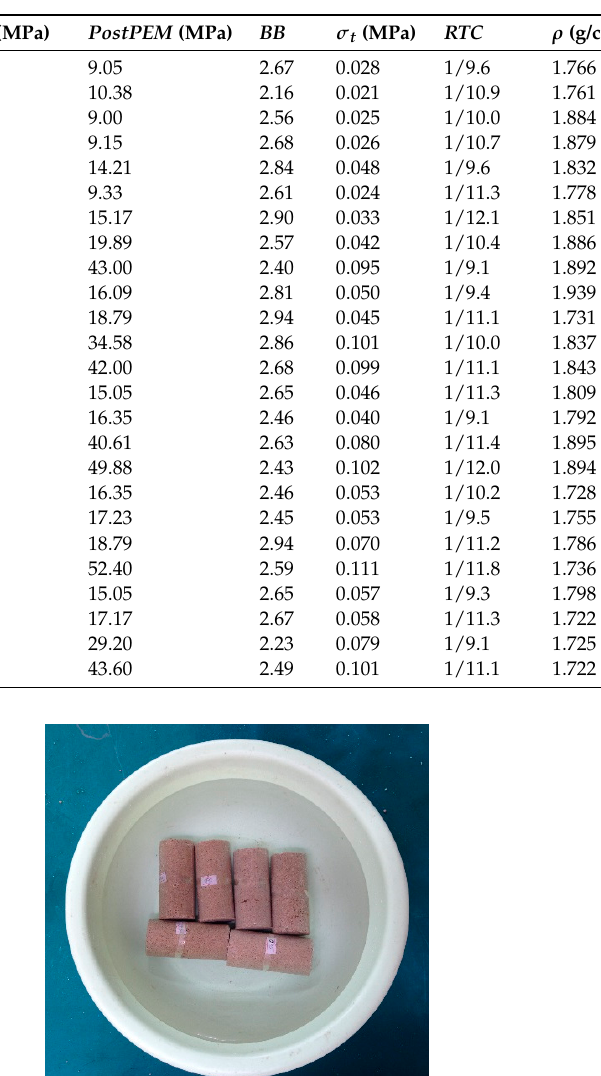
Table 3. The index parameters of specimens ( PrePEM : pre-peak elastic modulus; PostPEM : post peak elastic modulus; BB : brittle behavior; RTC : the ratio of uniaxial tensile strength and uniaxial compressive strength).